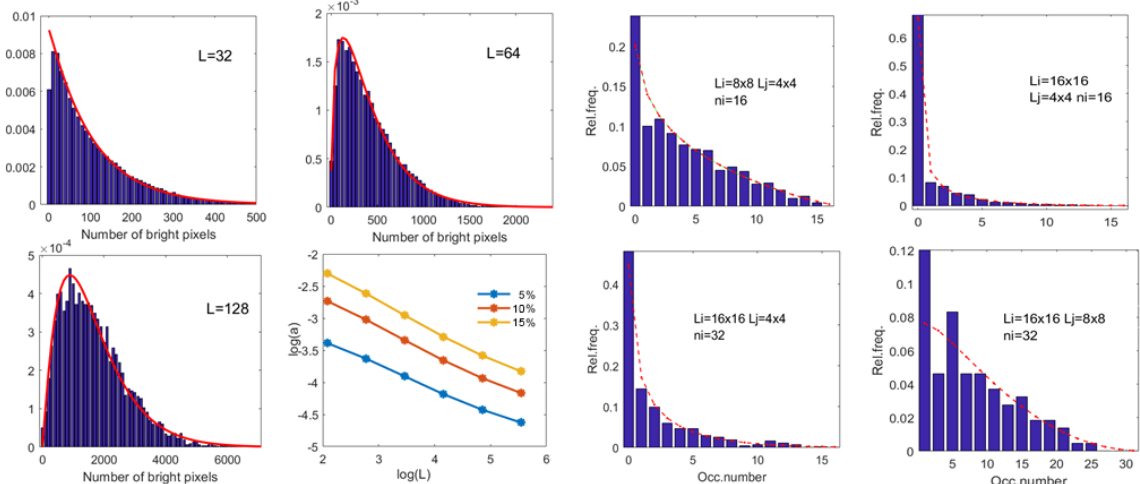
Figure 9. In the left panel group are BPN distributions and their negative binomial fits for BPP 10% and three different pixel block side lengths L . The parameter a is also shown for a scale cascade 8 , 16 ,..., 256 and for three different BPPs. In the right panel group are hypergeometric fits for conditional BPN distributions for different combinations of conditioning scale L i and conditioning BPN n i